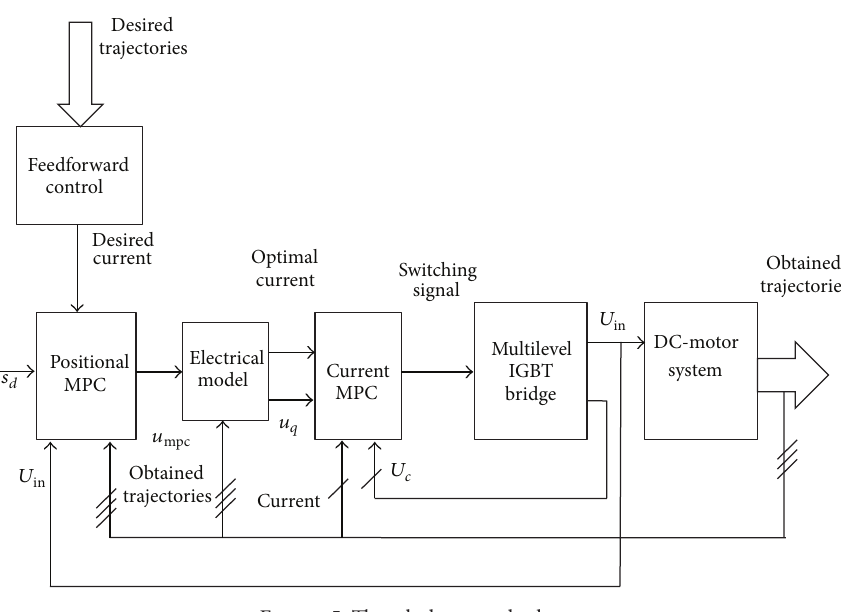
Figure 5: The whole control